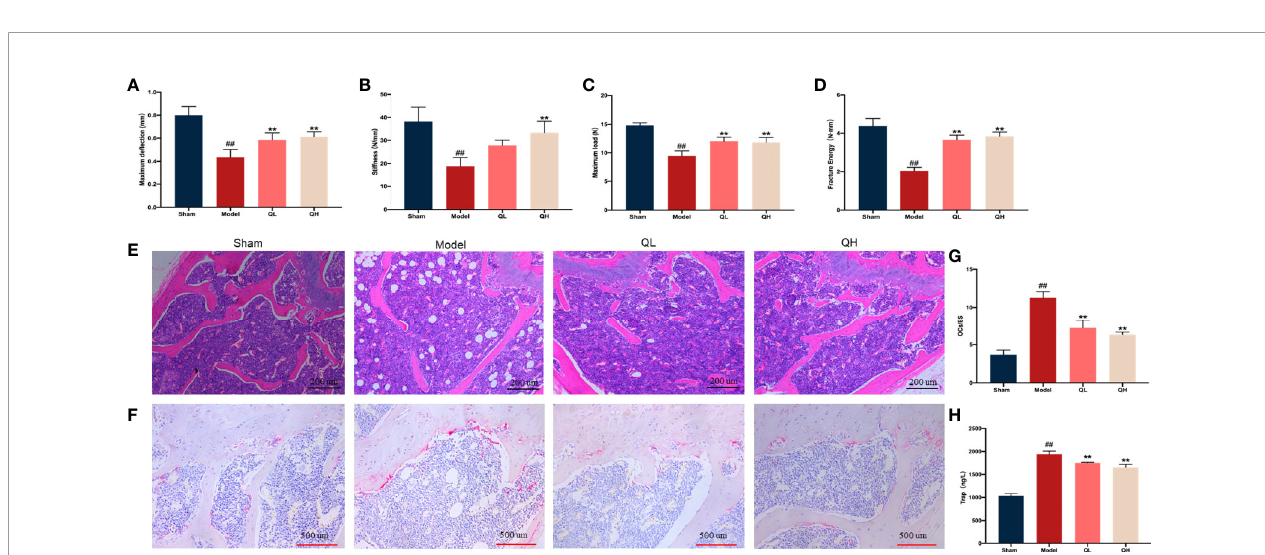
FIGURE 3 | Effects of quercetin on the biomechanical characteristics and capacity for bone resorption in mice that underwent orchiectomy. (A – D) Changes in the biomechanical characteristics in femur: including the maximum load and de fl ection, fracture energy, and stiffness. (E) The effects of quercetin on bone microstructure in the distal femoral bone, visualized by H&E staining. (F) Effects of quercetin on the bone resorption in mice that underwent orchiectomy, visualized by TRAP staining. (G) Osteoclast surface/bone surface (OC.s/BS). (H) Changes in serum levels of TRAP in mice that have undergone orchiectomy. ## p< 0.01 vs. sham group; ** p< 0.01 vs. model